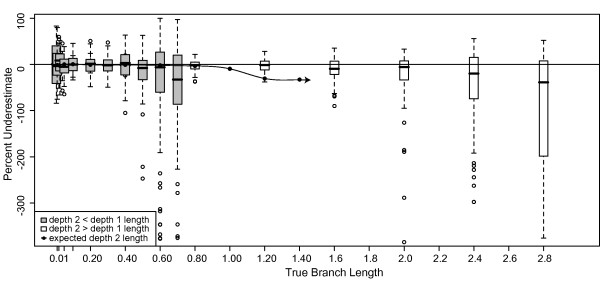
Underestimate of ML branch lengths on unequal branch length trees. Effects of unequal branch lengths on branch length estimation in a maximum likelihood framework. Results are plotted as for Figure 4. Gray boxes are the percent underestimation of depth 2 branch lengths for 4-taxon trees with the depth 2 branch length = half the depth 1 branch length. White boxes are the percent underestimation of depth 2 branch lengths for 4-taxon trees with the depth 2 branch length = double the depth 1 branch length (outliers of up to -30000% for branches of 1.4 substitutions/site are not shown for clarity). Depth 2 branch lengths were expected to be underestimated at the same rate as depth 2 branch lengths of 8-taxon equal-branch-length datasets (mean underestimation shown as filled circles). Half-length depth 2 branches (gray boxes) were generally overestimated (negatively underestimated) at a higher rate than expected (filled circles). Double-length depth 2 branches (white boxes) were overestimated at a lower rate than expected (filled circles and extrapolating from the trend of underestimation (spline interpolation line)).